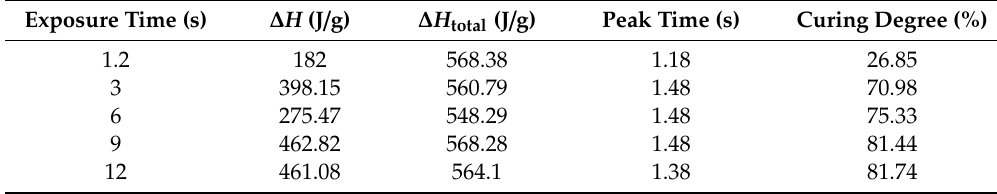
Table 2. Thermal properties analysis results for different exposure times.